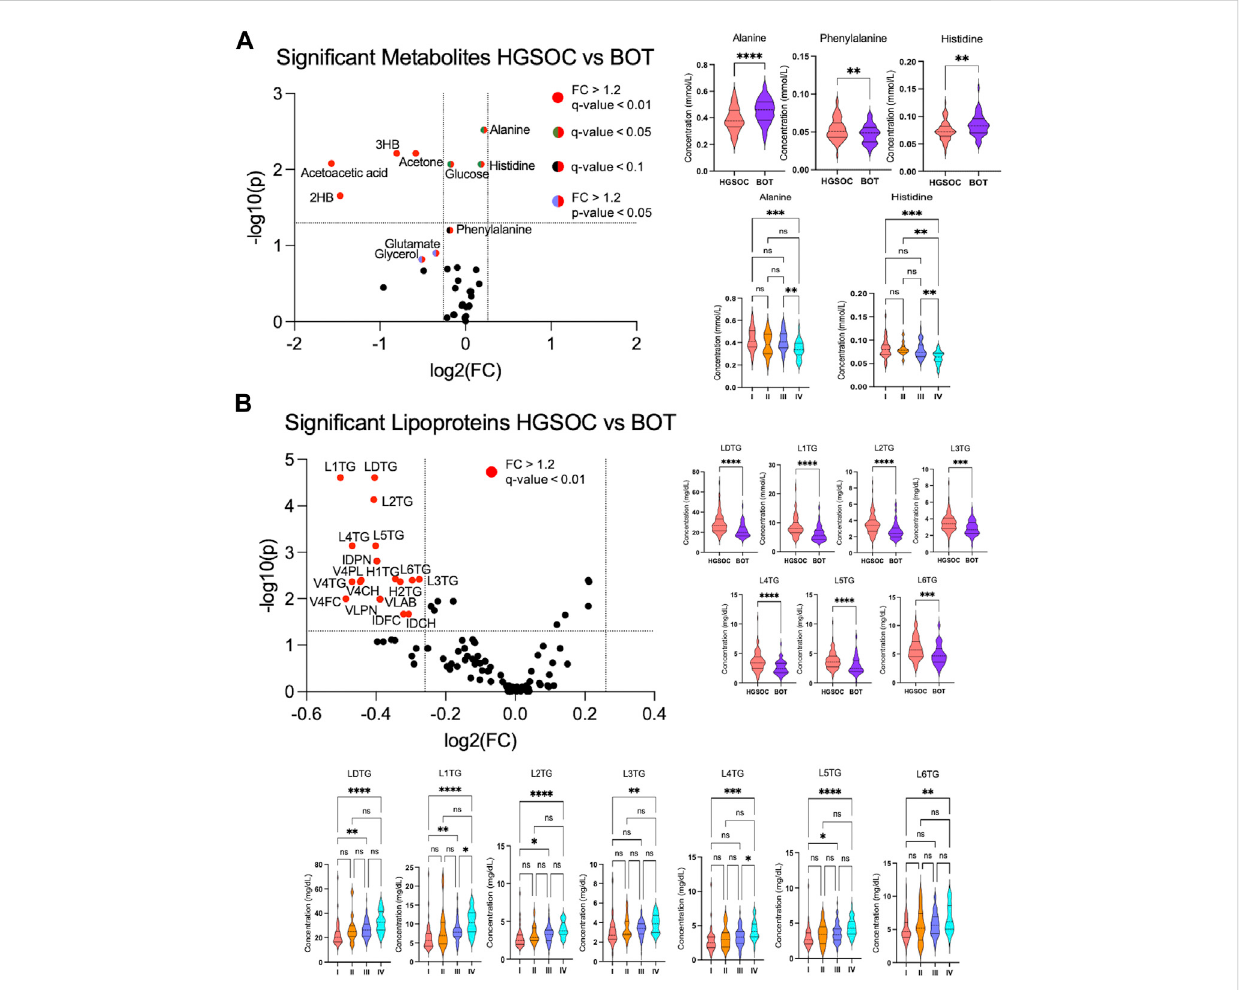
FIGURE 3 Altered metabolites and lipoproteins in borderline ovarian tumor (BOT) and high-grade serous ovarian cancer (HGSOC) with clinical stages I – IV. From left: (A, B) volcano plot showing statistically and biologically signi fi cant metabolites and lipoproteins in the histology of ovarian cancer; red plots indicate upregulation in high-grade serous ovarian cancer (fold change > 1.2 and p -value < 0.05). From right: (A, B) violin plots by comparative statistics showing signi fi cantly altered alanine (FDR < 0.01), phenylalanine (FDR < 0.1), and histidine (FDR < 0.01) in high-grade serous ovarian cancer (** < 0.01 and **** < 0.0001) and signi fi cantly altered alanine and histidine over the clinical stages (q-value = ** < 0.01 and *** < 0.001). From right: (B and bottom) violin plots displaying signi fi cantly altered lipoproteins in high-grade serous ovarian cancer (FDR < 0.01, *** < 0.001, and **** < 0.0001) and over the clinical stages (q-value = (* < 0.05, ** < 0.01, *** < 0.001, and **** <